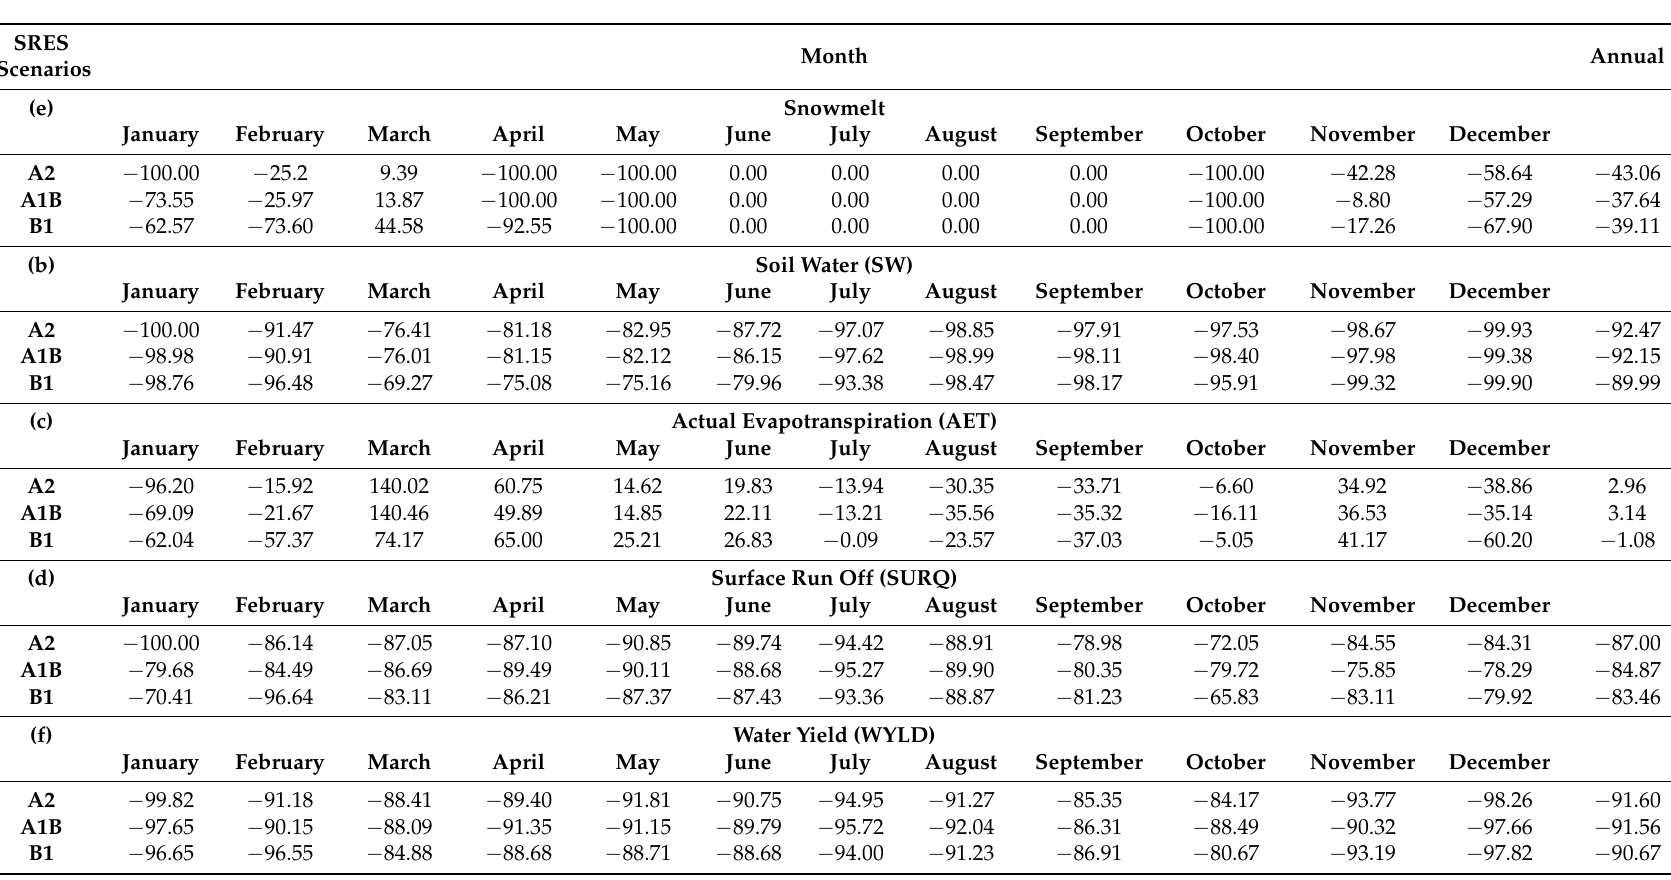
Table A3. Variation in different hydrologic components in percentage on monthly and annual time step compared to baseline in response to projected climate change